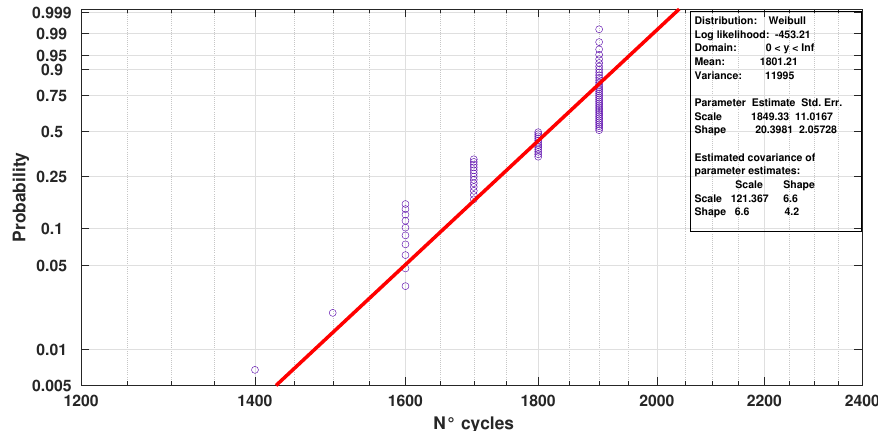
Figure 6. Graphical representation of data using the Weibull distribution. Purple dots represent the Solder Joints of an LED (SJLs) that reached the failure at every thermal cycle; the red line describes the distribution curve of the faults.